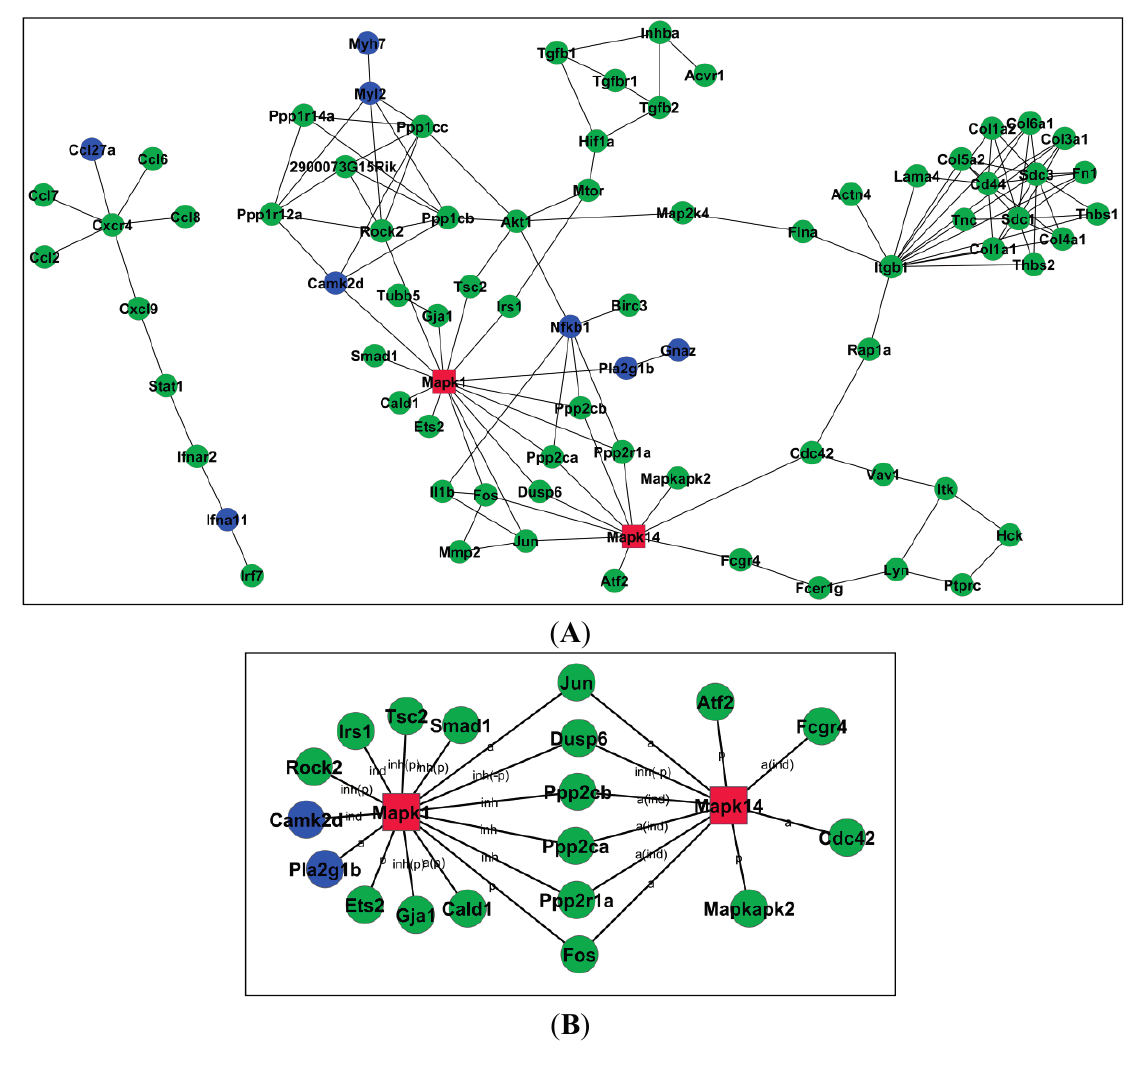
Figure 4. Signal–Net analysis of DE genes in significant pathways. The circles represent genes (blue, down-regulated; other colors, up-regulated. Mapk1 and Mapk14 associated with apoptosis in red). The size of the area represents the degree. ( A ) The differentially expressed mRNAs between curcumin/MMC at the doses of 1.5 and 1.0 mg/kg was observed. Gene regulatory networks based on Signal–Net database was established; ( B ) Apoptosis-related genes such as Mapk1 and Mapk14 were included. The relationship among of apoptosis-related genes was